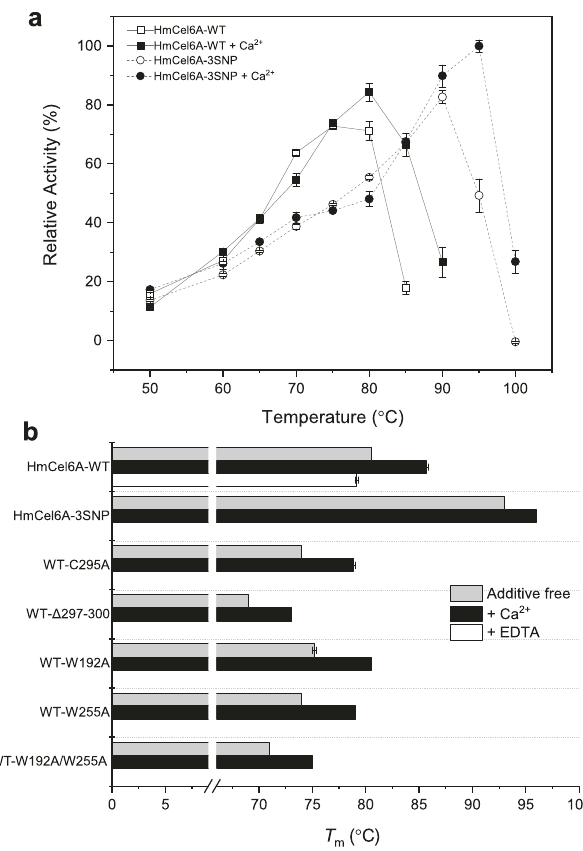
Fig. 2 Enzymatic properties of HmCel6A. a Optimum temperature ( T opt ) of HmCel6A and its 3SNP variant with the PSA substrate in the presence (solid squares and circles) and absence (white squares and circles) of 3 mM CaCl 2 . b Melting temperature ( T m ) of wild-type and mutant enzymes in the presence (black bars) and absence (grey bars) of 3 mM Ca 2 + / 40 mM EDTA, as determined in a thermal shift assay. Each error bar represents the standard